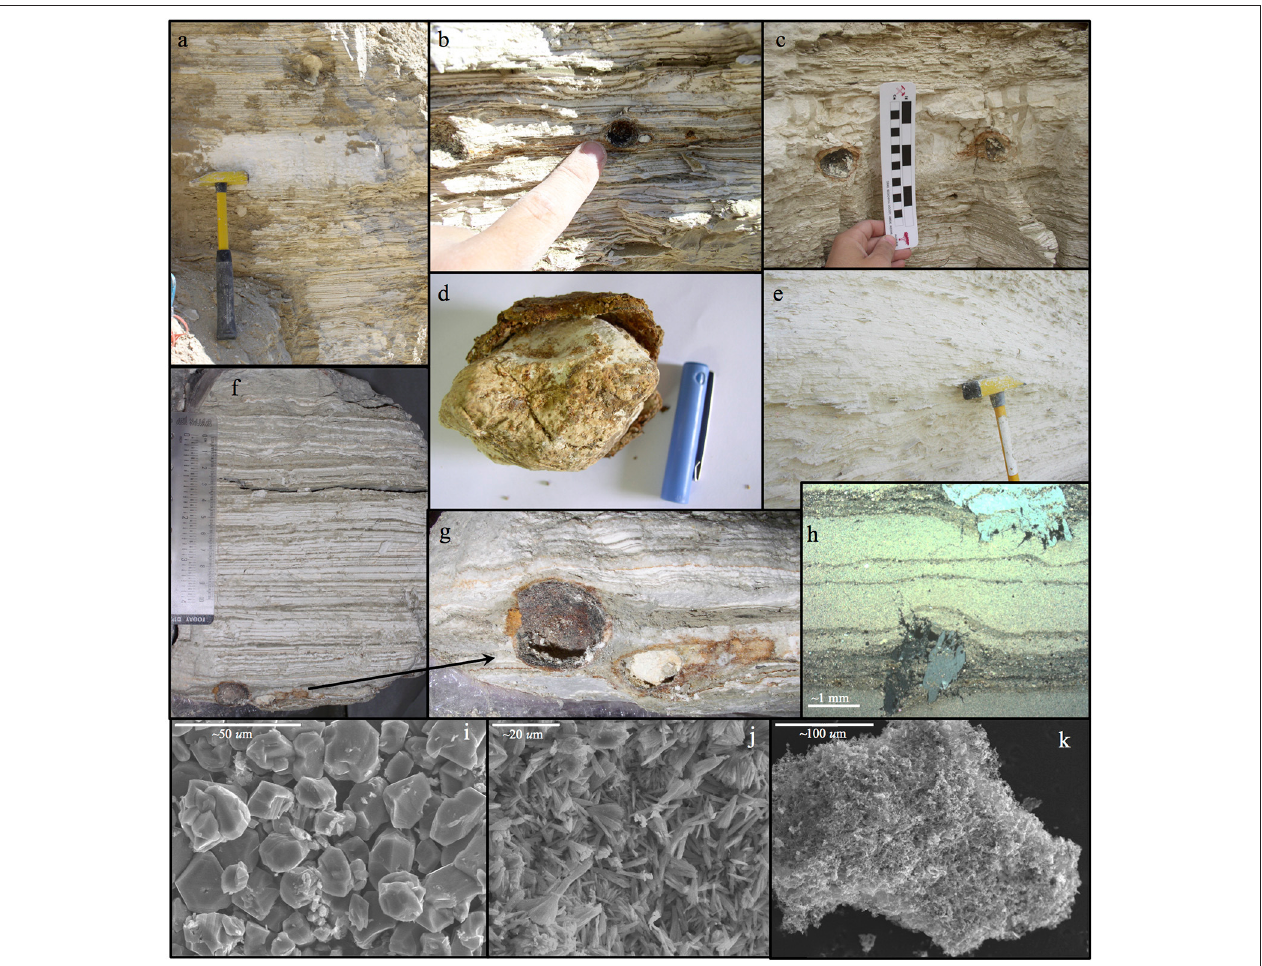
FIGURE 3 | (a) Native sulfur nodule in aragonite-detritus sequence ∼ 20 cm above the Lower Gypsum Unit (M1), (b) Nodules in aragonite-detritus outcrop. The black coating of the extracted nodules and the yellow native sulfur nodule on the right, (c) Native sulfur nodules in massive gypsum layer, (d) Native sulfur nodule in its crust, comprised of secondary gypsum and Fe-oxides, (e) Aragonite-detritus sequence of the Lisan Formation at M1. The abundant secondary gypsum concretions and bulges throughout the sequence, (f,g) Native sulfur nodules at the base of a field sample extracted from between the gypsum units comprising the Lower Gypsum Unit at M1, (h) Thin section under polarized light exhibiting micro secondary gypsum concretions offsetting surrounding aragonite laminae (from Haliva-Cohen et al., 2012 ). The concretion at the lower part of (h) is ∼ 1 mm thick from bottom to top, (i) SEM magnification of primary gypsum crystals, (j) SEM magnification of aragonite needles, (k) SEM magnification of a native sulfur